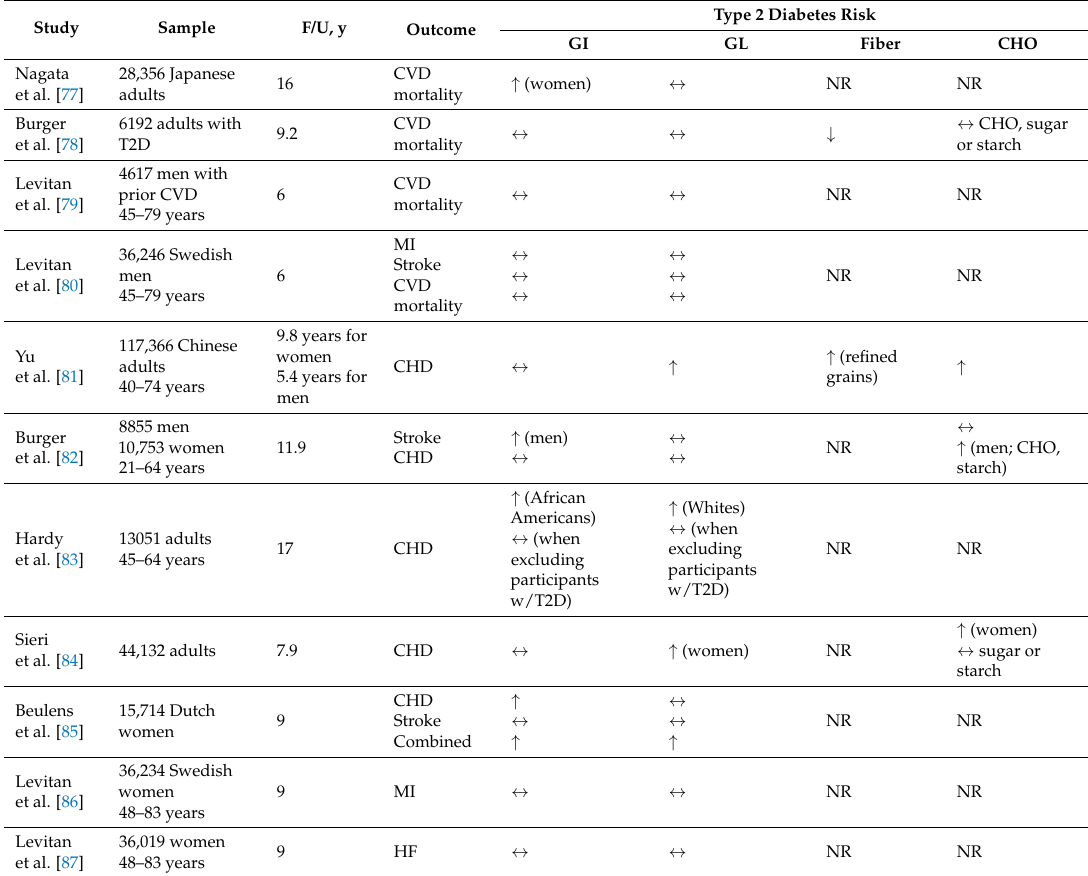
Table 9. Prospective studies assessing the effects glycemic index or glycemic load on cardiovascular disease risk 1